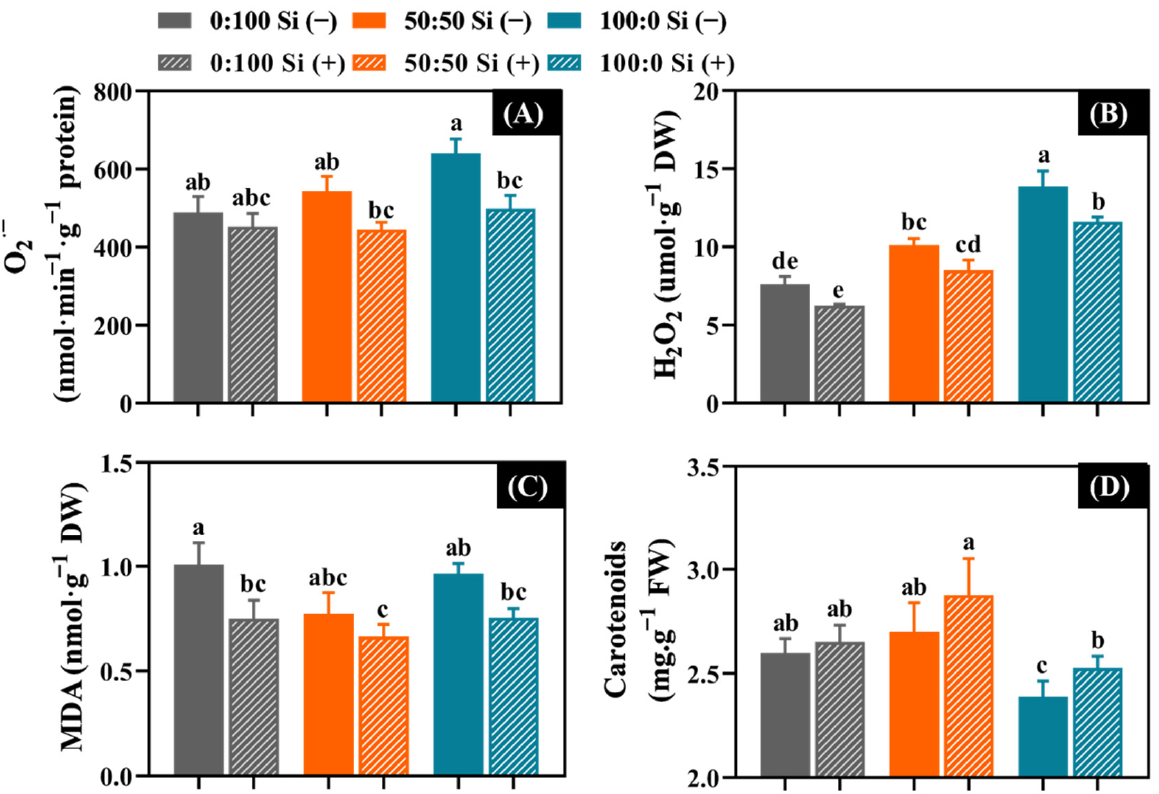
Figure 6. The impact of the N form with or without Si supplementation on the content of ( A ) superoxide anion (O 2· − ), ( B ) hydrogen peroxide (H 2 O 2 ), ( C ) malondialdehyde (MDA), and ( D ) carotenoids. n = 6 technical replicates were averaged and statistically analyzed using the Duncan’s multiple range test at p = 0.05. Significant differences were denoted by different lowercase letters. Error bars indicate mean ± standard deviation (SD).